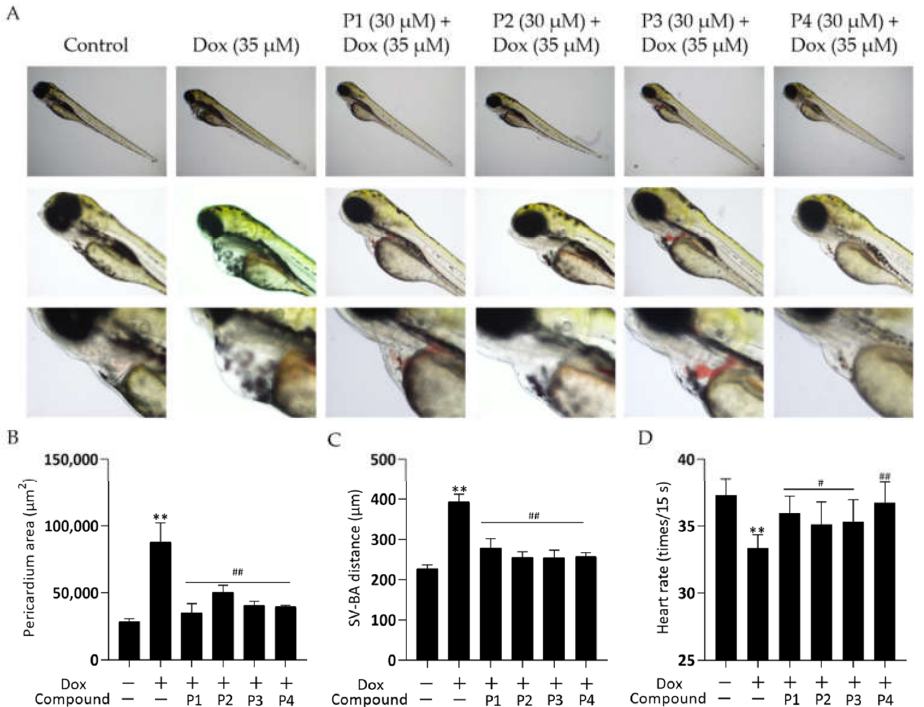
Figure 2. Effects of phenylpropanoids of Hippophae rhamnoides L. on doxorubicin-induced cardiac injury in zebrafish. ( A ) Representative photographs of zebrafish pericardium collected using a DMi1 optical inverted microscope. ( B ) Column chart of pericardial edema in each group obtained by quantifying the pericardial area using ImageJ software. ( C ) Column chart of the distance between sinus venosus and bulbus arteriosus obtained using microscopy. ( D ) Column chart of heart rate per 15 s in zebrafish larvae. ** p < 0.01 vs. the control group; # p < 0.05, ## p < 0.01 vs. the Dox group.